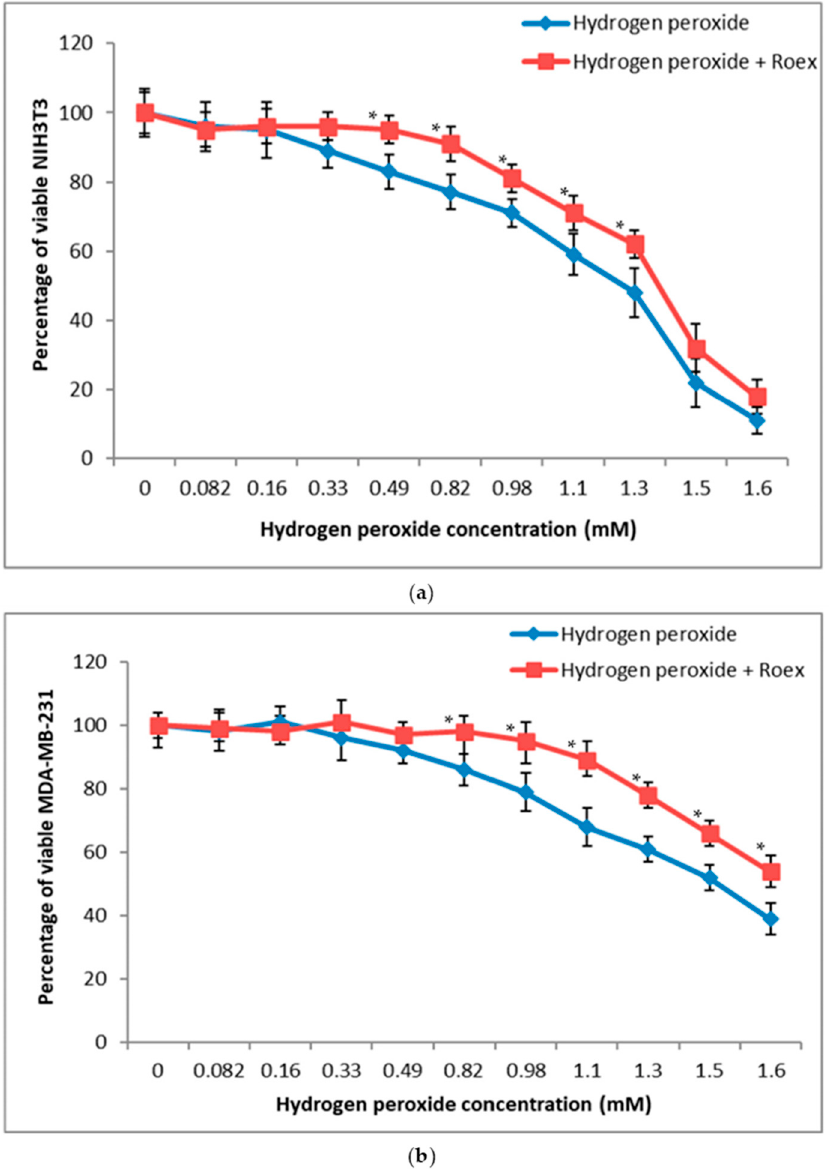
Figure 4. Influence of hydrogen peroxide pre-treatment on viability of ( a ) NIH3T3 and ( b ) MDA-MB-231. * Values are statistically different versus H 2 O 2 treated cells, p < 0.05.